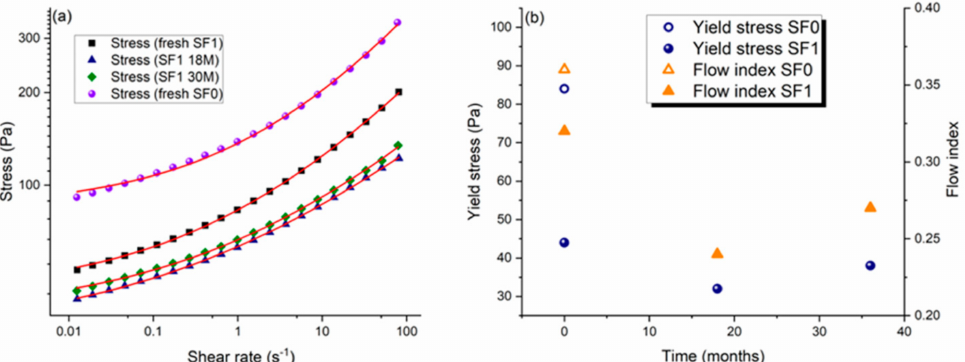
Figure 2. Influence of aging time on the rheological properties of a CBR gel with 1 wt.% surfactant (gel SF1). ( a ) Shear stress as a function of shear rate with experimental data points and lines of best fit using the Herschel–Bulkley model for aged samples of SF1 gel and a fresh sample of SF0 gel. ( b ) Yield stress and flow index as a function of storage time obtained from the fits using the Herschel–Bulkley